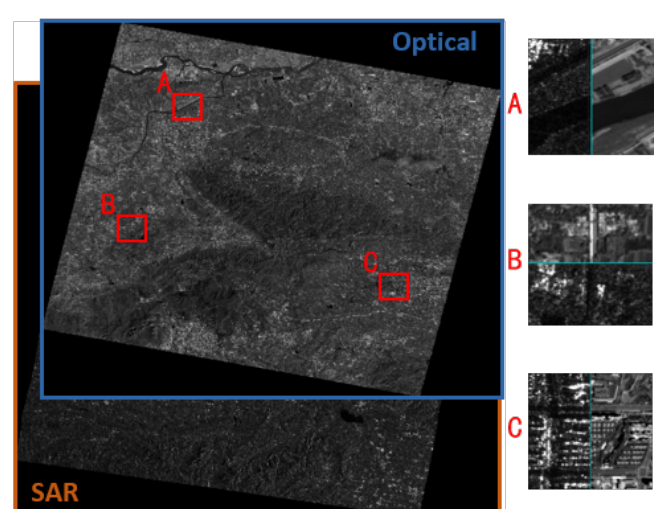
Figure 12. The pair B.